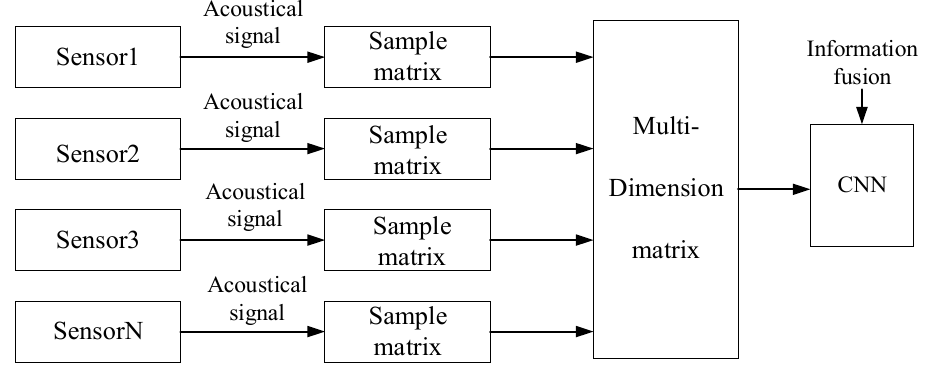
Figure 2. Multi-channel information fusion flowchart.